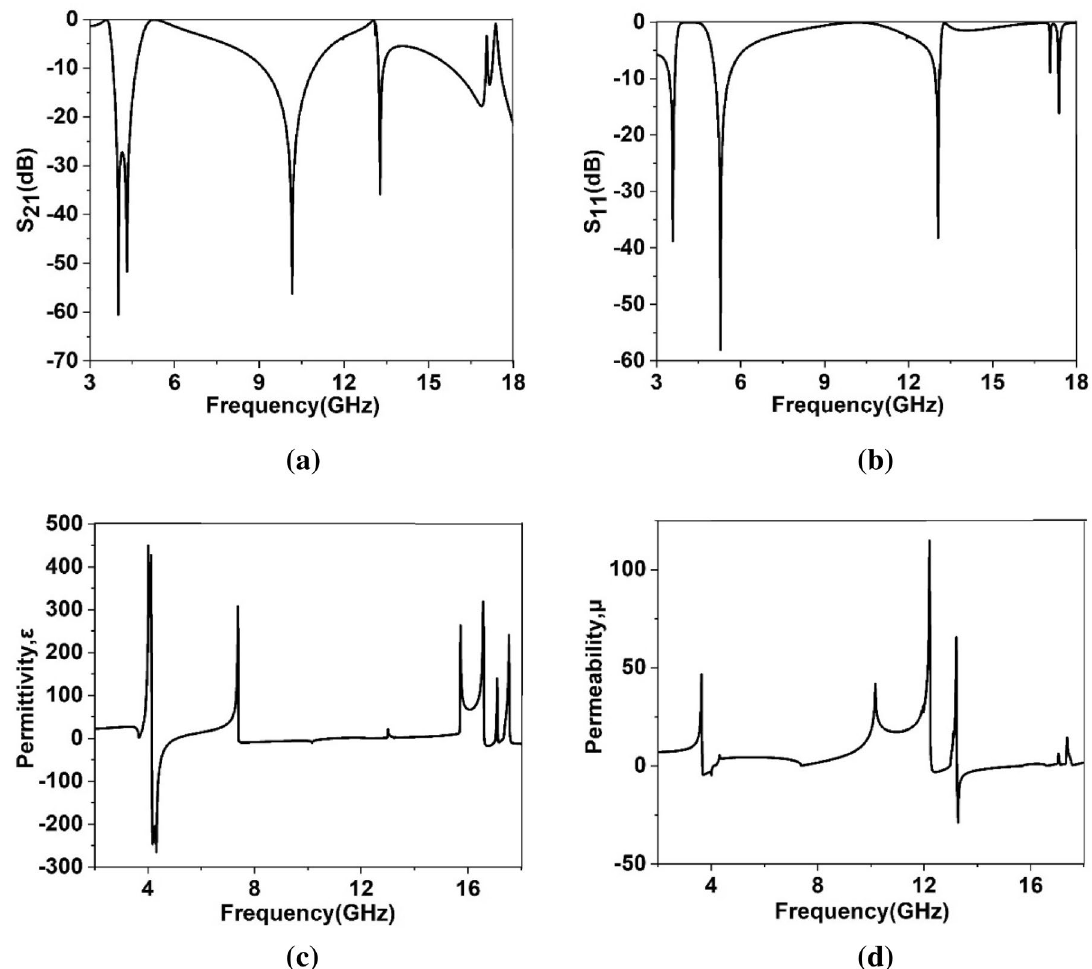
Figure 15. ( a ) Transmisson coefficient (S 21 ) ( b ) reflection coefficien (S 11 ) ( c ) permittivity ( d ) permeability where ports are assigned in Y